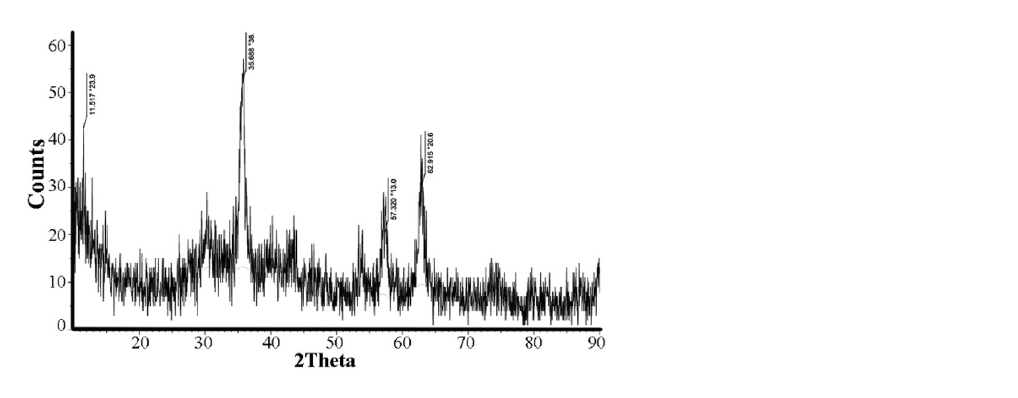
Figure 2. XRD pattern of Pd@m FuVe NPs